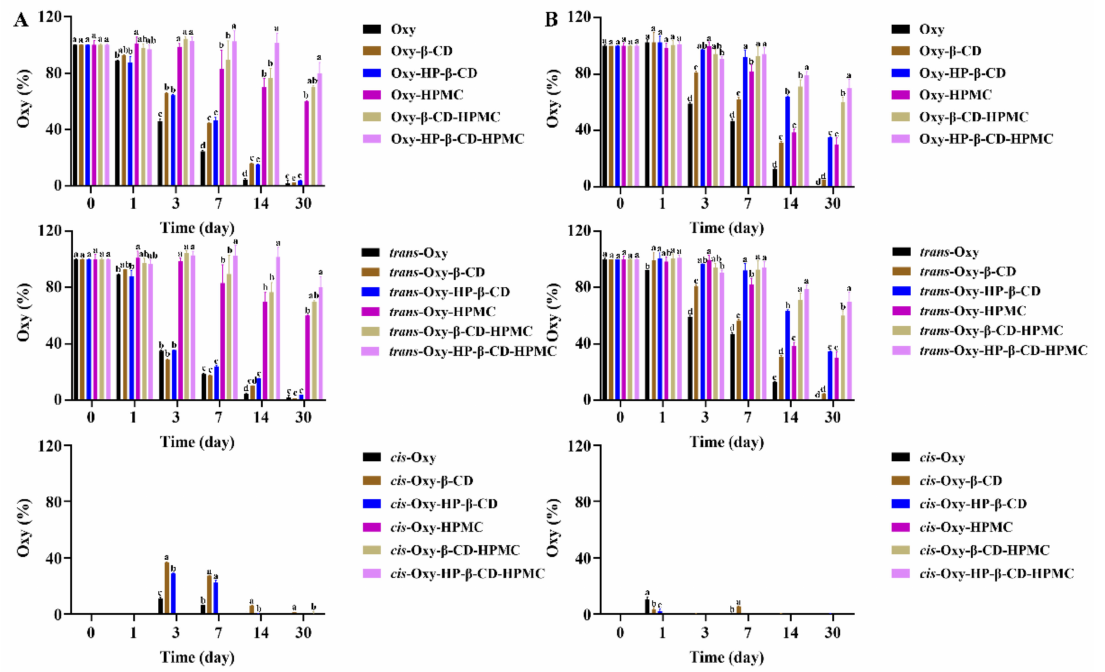
Figure 10. The percentage of remaining Oxy (both trans - and cis -forms) in Oxy, Oxy–HPMC, Oxy– CD, and Oxy–CD–HPMC solutions during 30 days of storage at 50 ◦ C with light was recorded by monitoring Oxy content with HPLC at a certain time interval ( n = 3, if no error bars are displayed, errors were smaller than symbols). Data were presented as mean ± SD, and significant differences compared to the pure Oxy group are shown with lower case letters a–e. All samples were stored in well-closed glass bottles. ( A ) Water; ( B ) acidic solution (pH